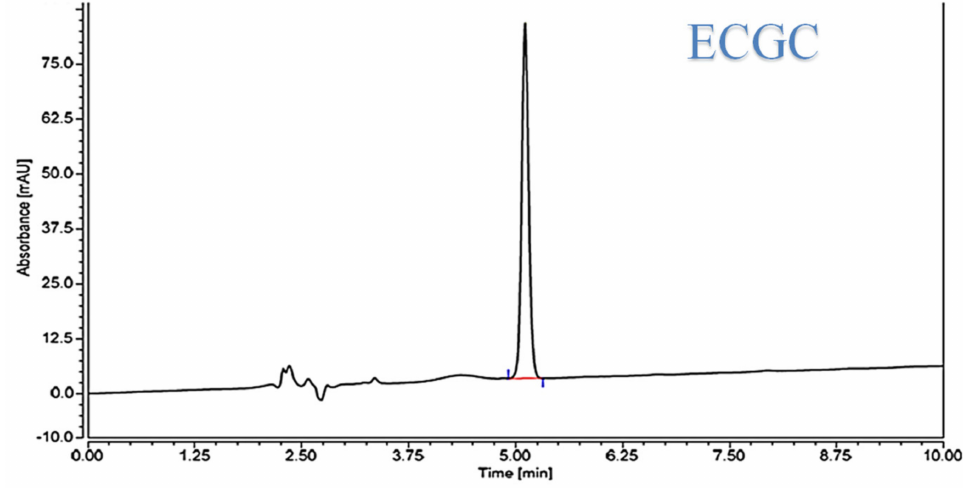
Figure 1. HPLC chromatogram of